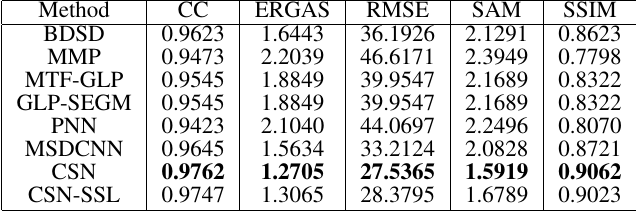
Table 1. Objective performance of the pan-sharpening methods on reduced-resolution test set.